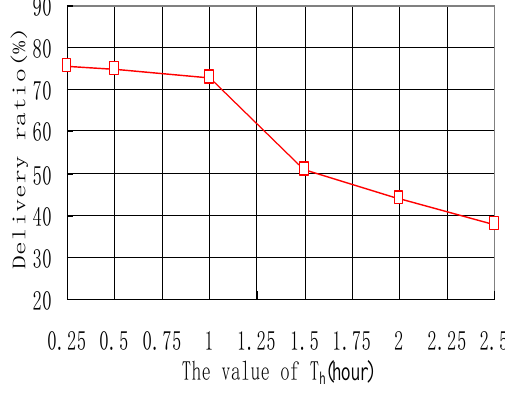
Figure 6. data delivery vs. value of Th.